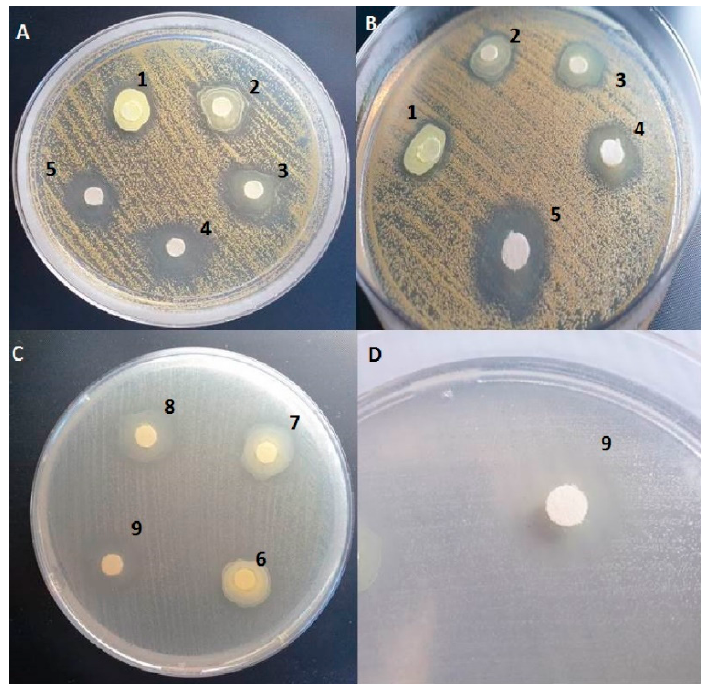
Figure 5. Inhibition zones of S.aureus in result of activity of compounds 6d ( A , B ) activity. Inhibition zones of E. faecalis in result of activity of compounds 7f ( C , D ) activity. Applied compounds’ quantities [mg / disc]: 1 = 0.5 mg; 2 = 0.25 mg; 3 = 0.125 mg; 4 = 0.0625 mg; 5 = 0.0312 mg; 6 = 0.25 mg; 7 = 0.125 mg; 8 = 0.0625 mg; 9 = 0.0312 mg. Table 5. In vitro antimicrobial activity [MIC [mg / mL] of tested compounds vs. clinically used